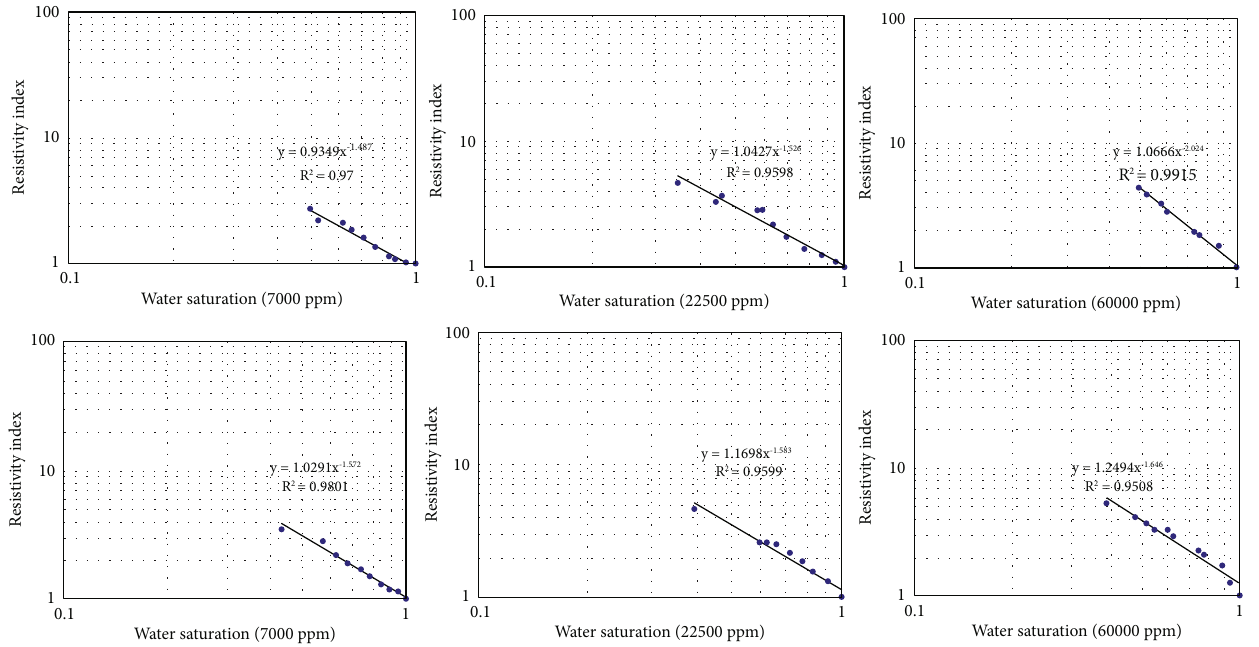
Figure 7: Resistivity index vs. water saturation in sample L4 ( fi rst row) and L53 (second